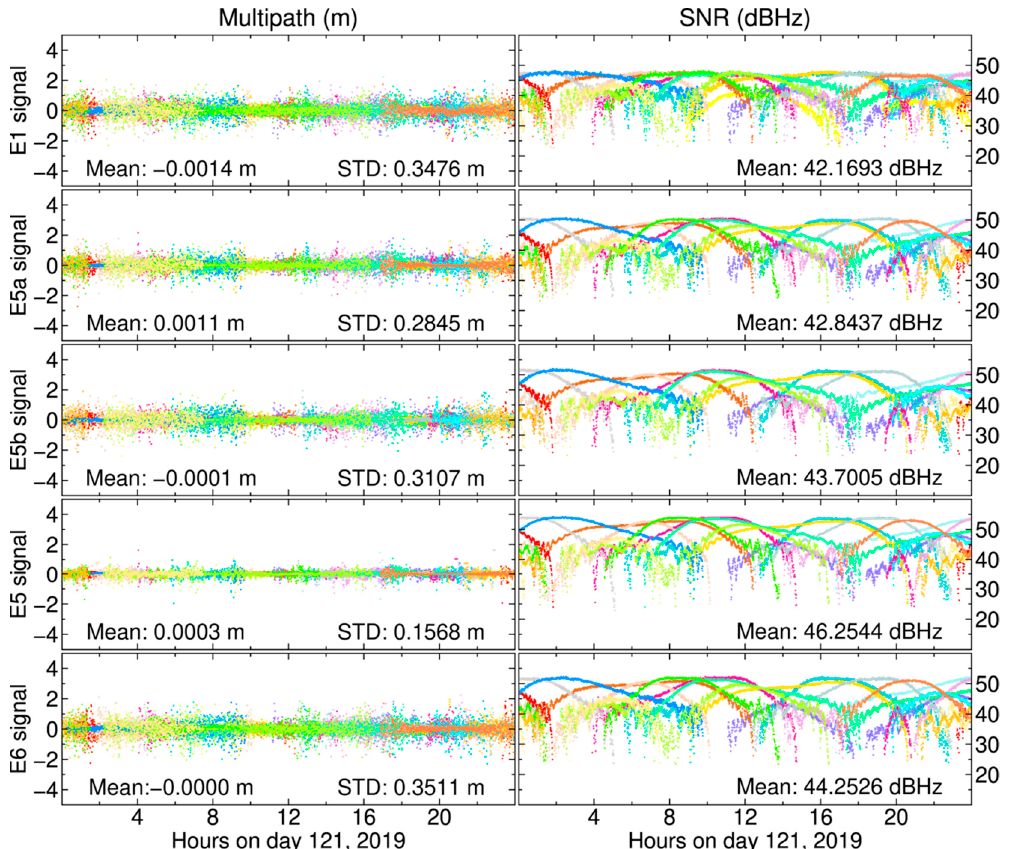
Figure 3. Galileo signal quality analysis for E1, E5a, E5b, E5, and E6. ( left ) The pseudo-range multipath results for all observed Galileo satellites; ( right ) signal-to-noise ratio (SNR) values for all observed Galileo satellites. Di ff erent colors denote di ff erent Galileo